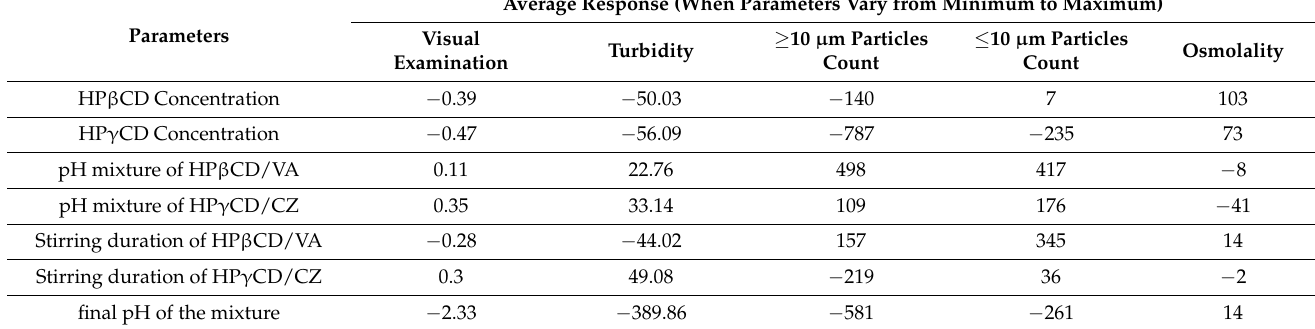
Table 2. Parameters relative impact on the studied responses according to the design of experiments. Hydroxypropyl- β - cyclodextrins: HP β CD; hydroxypropyl- γ -cyclodextrins: HP γ CD; VA: vancomycin; CZ: